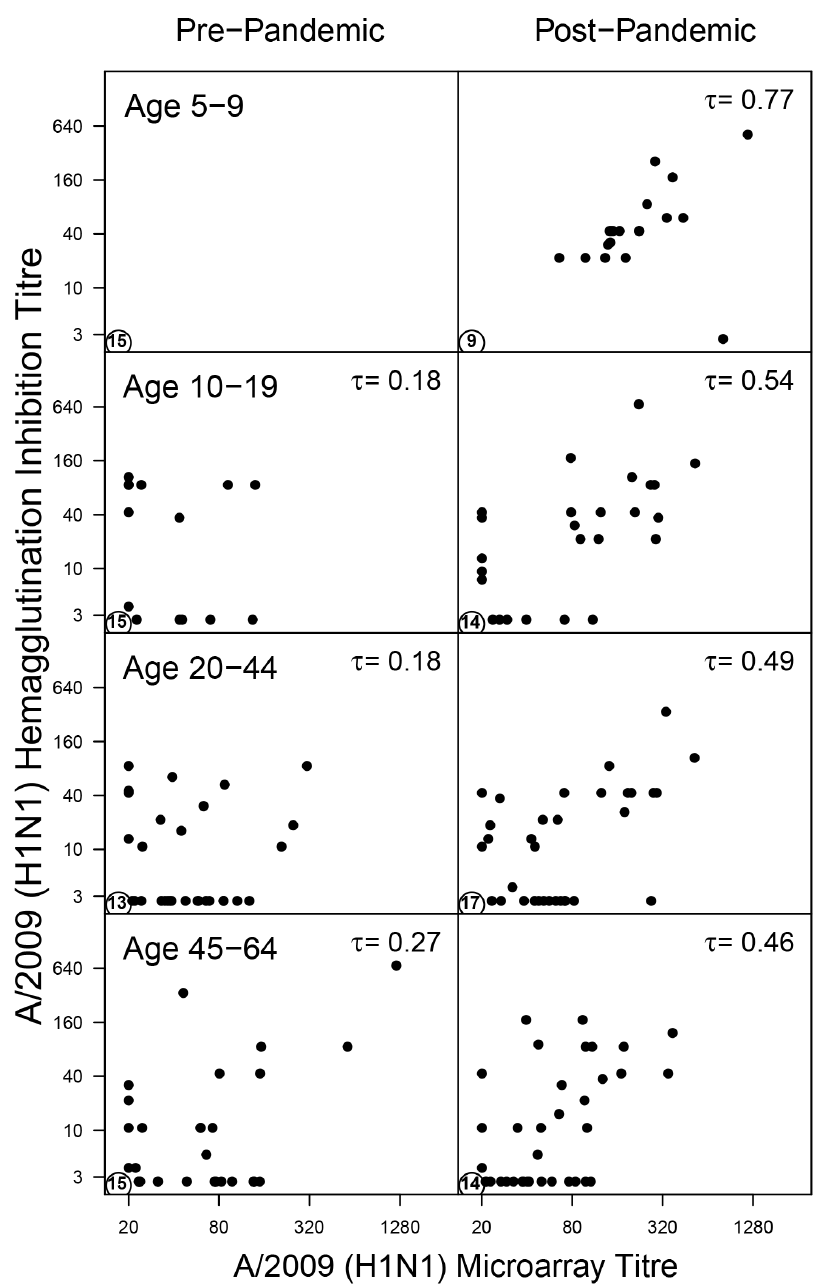
Figure 1. Standardised hemagglutination inhibition titers as a function of A/2009 microarray titers. Data are stratified by study and age group (5–9, 10–19, 20–44, and 45–65 years). The bottom left corner in each panel shows the number of samples that tested negative in both assays. The top right corner shows Kendall’s tau, a nonparametric correlation coefficient.